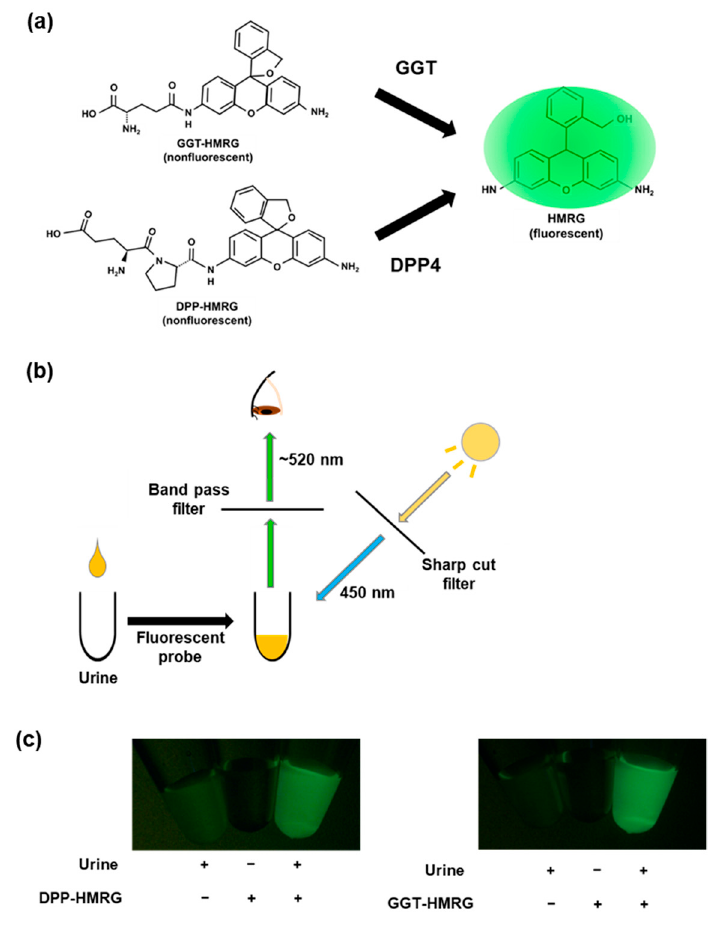
Figure 1. Urinary fluorescence analysis. ( a , b ) Scheme of fluorescence imaging using enzyme-activatable fluorescent probes. GGT-HMRG and DPP-HMRG are non-fluorescent but emit fluorescence upon activation by GGT or DPP. ( c ) Representative urinary fluorescence images after DPP-HMRG and GGT-HMRG. Although the urine showed a faint autofluorescence, remarkable fluorescence was observed after incubation with the fluorescent probes.